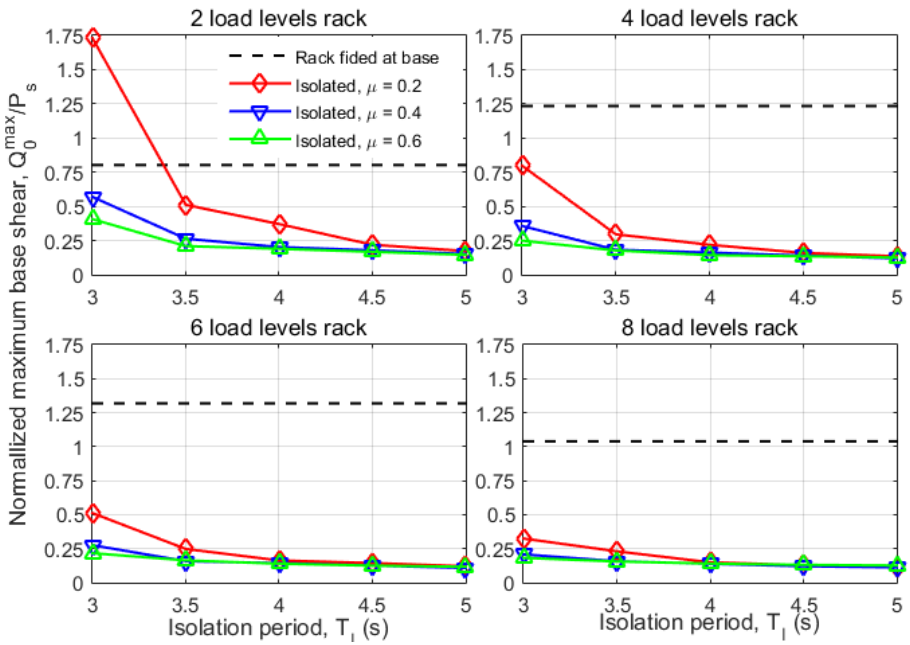
Figure 8. Maximum basal shear load in racks with base isolation with different load levels, friction coefficient ( μ ) and isolation period ( 𝑇 𝐼 ). The black dotted line is the response for fixed base racks.